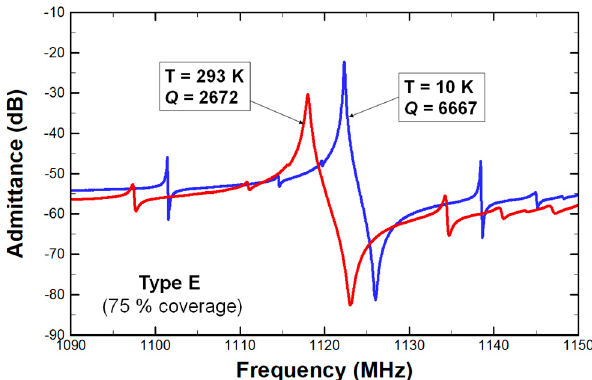
Figure 6. Admittance responses of 1.1 GHz (Type E with 75% bottom electrode coverage) at 293 and 10 K. Both Q and resonant frequencies ( f 0 ) depend on operating temperatures.